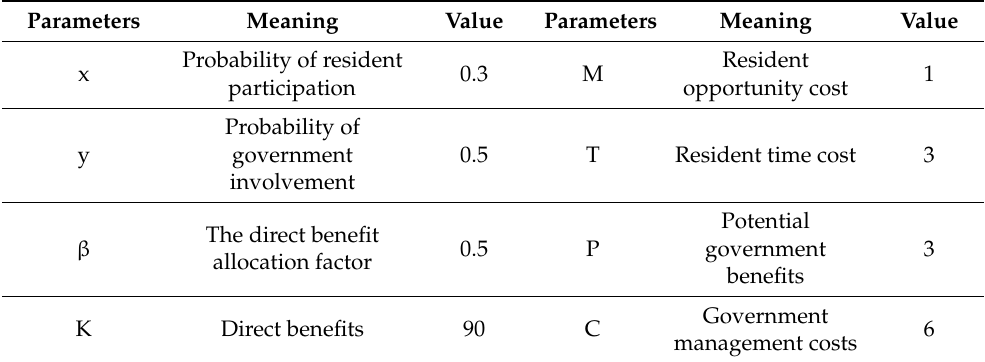
Table 4. Simulation parameter